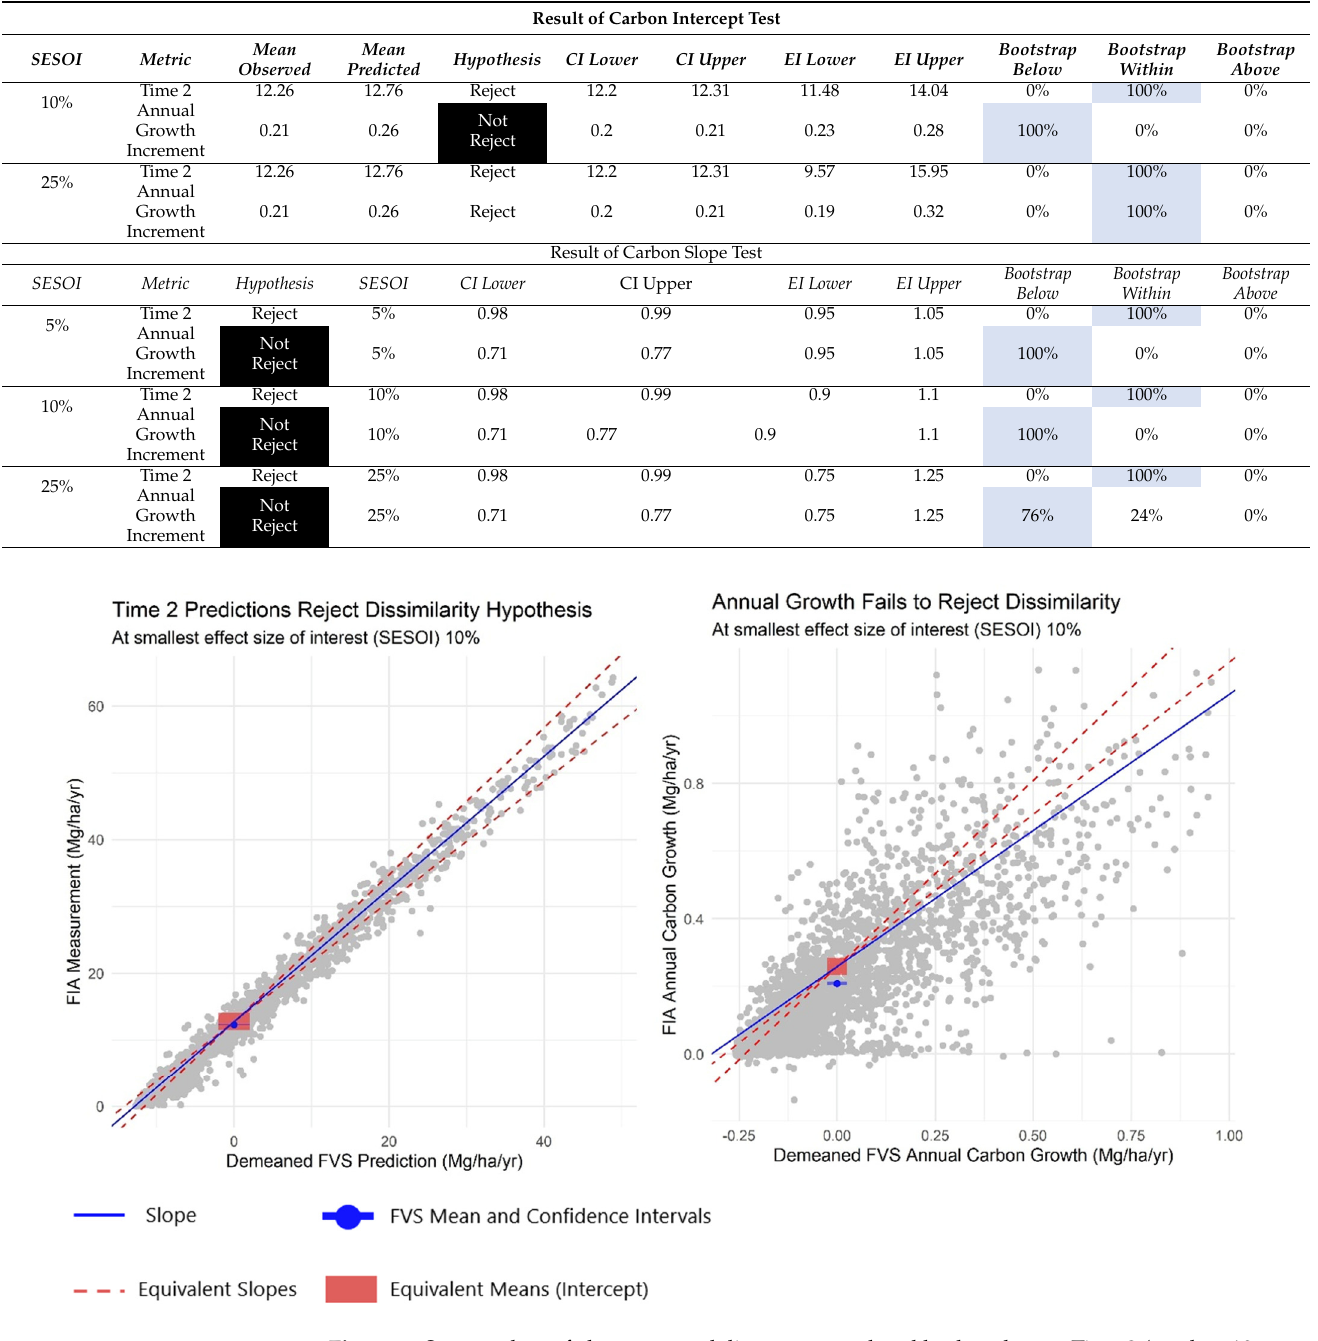
Figure 3. Scatter plots of above-ground, live tree, wood and bark carbon at Time 2 (stocks ~10 years following initial measurement) and Annualized Growth for stands with equivalence confidence in- tervals with smallest e ff ect size of interest (SESOI) at 10%.